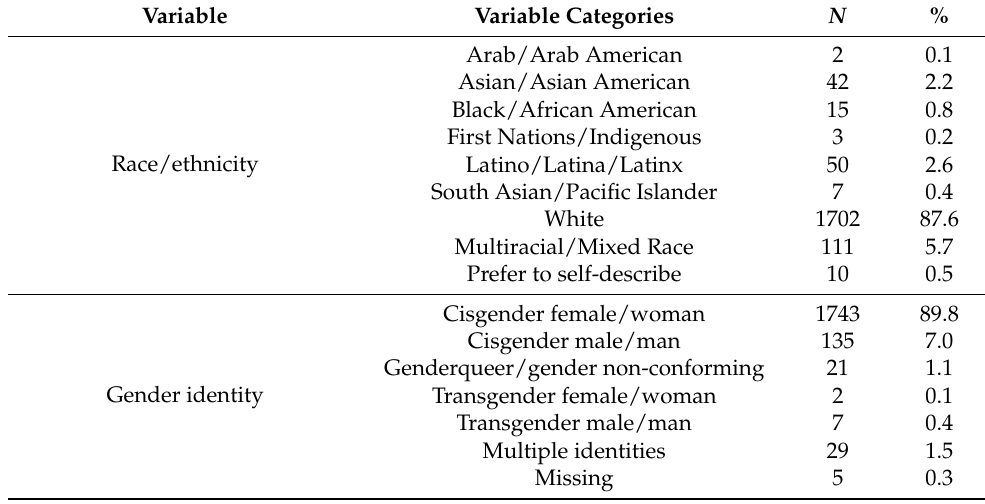
Table 1. Demographic characteristics of sample ( N =